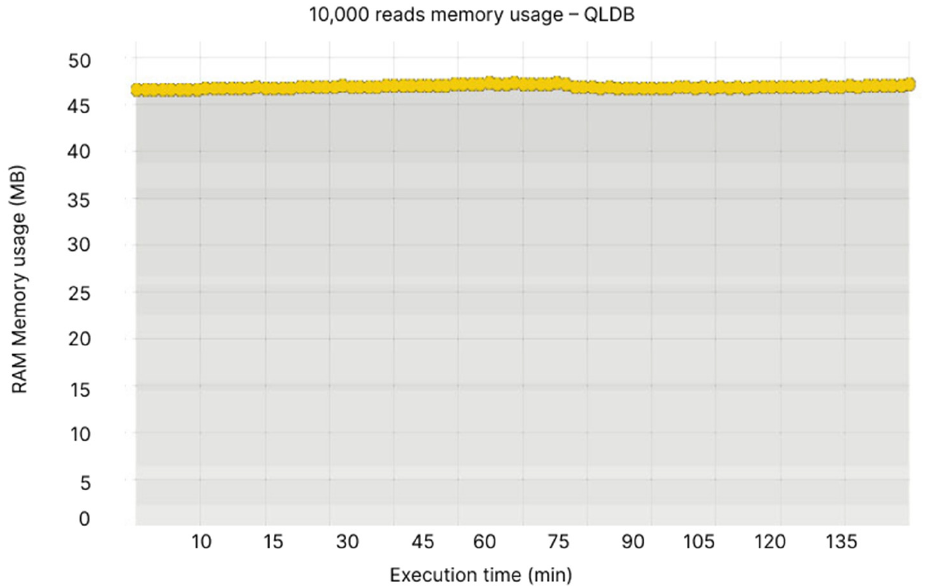
Figure 29. 10,000 reads memory usage—QLDB.